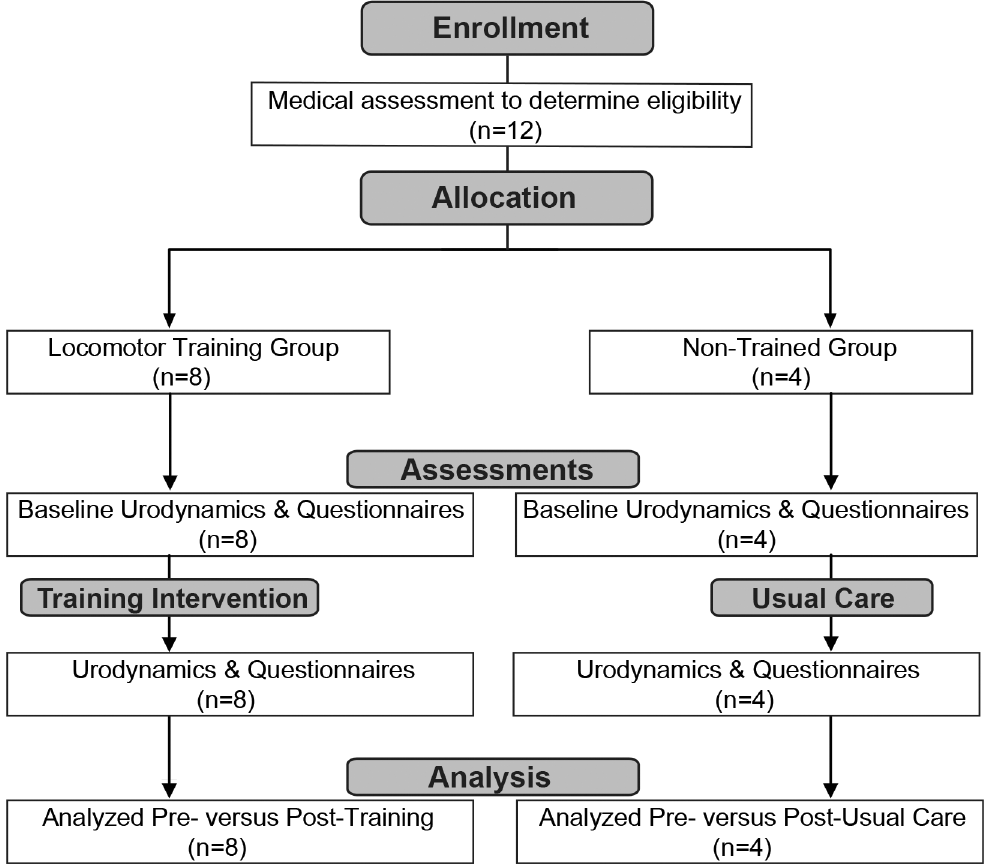
Fig 1. Methods flowchart. Urodynamic and questionnaires (bladder, bowel and sexual function assessments) were conducted after clinical evaluation for eligibility. After approximately 80 locomotor training sessions or usual care (at home in usual routine between assessments for an equivalent time period for 80 training sessions), assessments were repeated. Each participant served as their own control. Individual and group data were analyzed at the conclusion of the